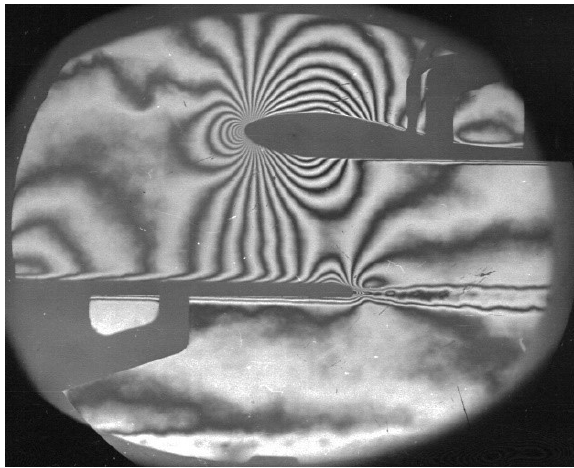
Figure 11. Section near the tip, ι = − 6 . 5 ◦ , M